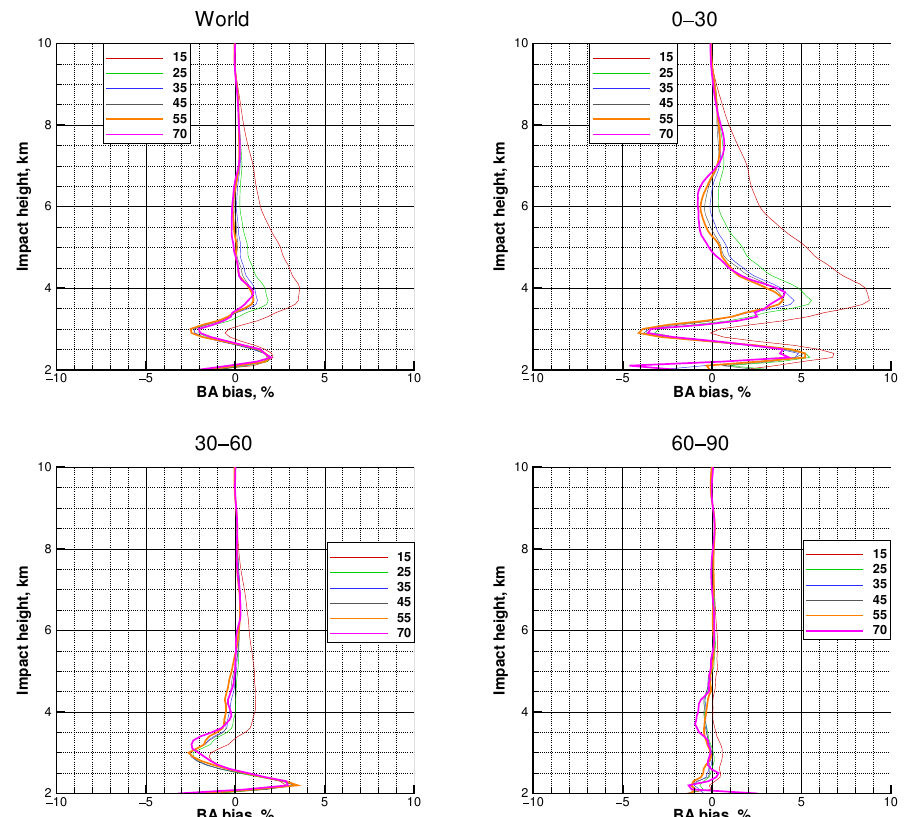
Figure 8. Similar to Figure 2. Spire, systematic